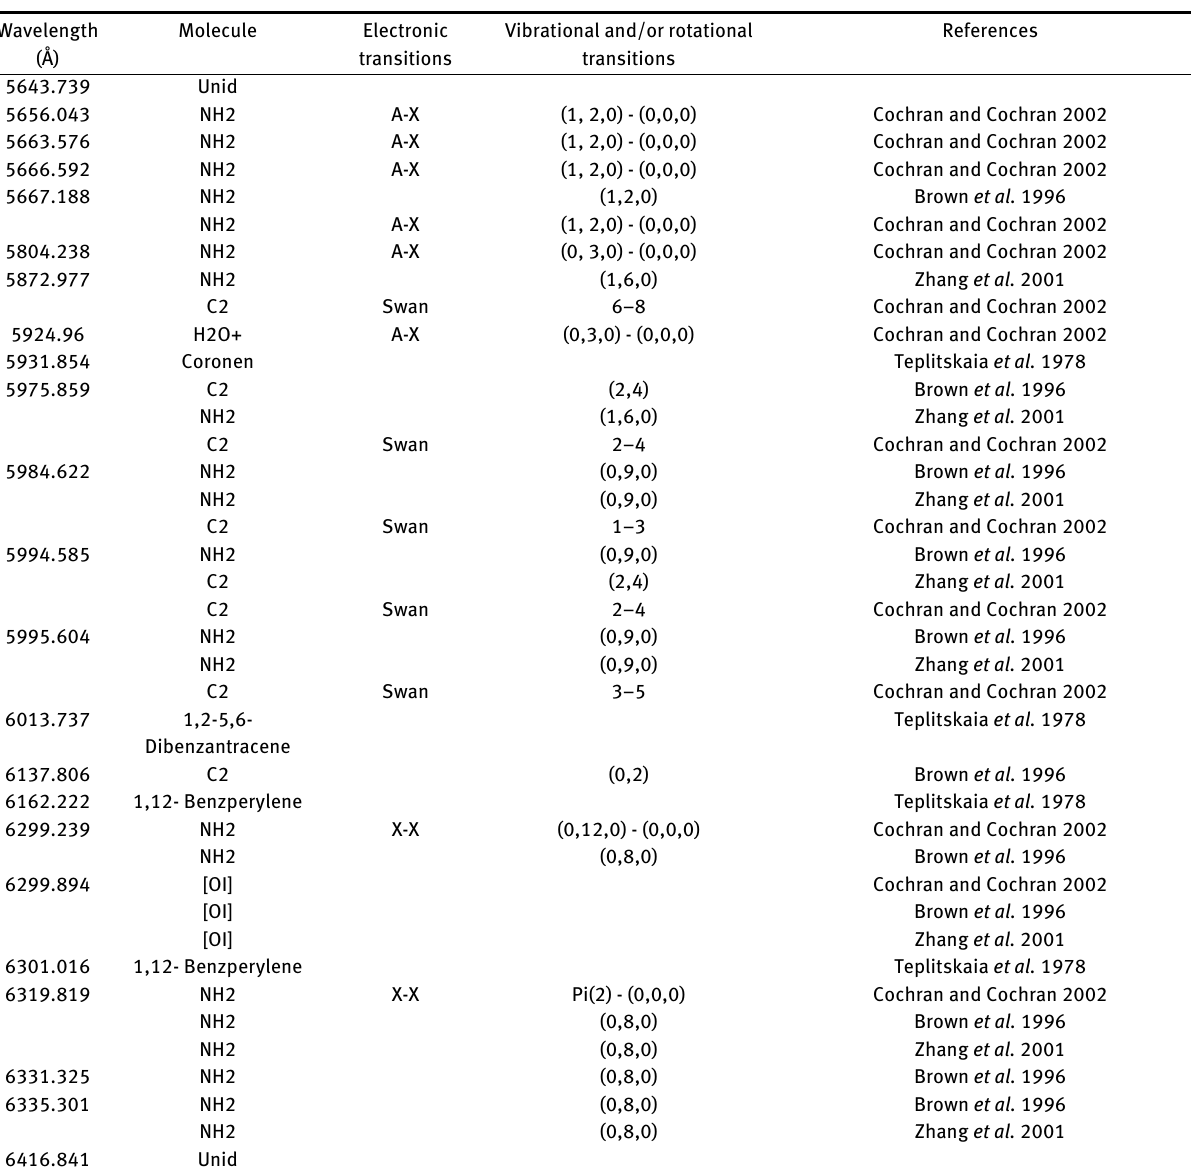
Table 1. Identified molecules in the matter of C/1999 S4